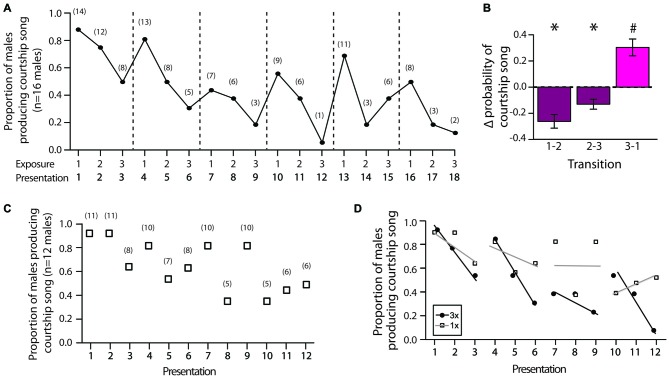
Decreases in the production of courtship song reflect the formation of short-term memories. (A) Plotted are the proportion of male Bengalese finches (n = 16) that produced courtship song across each exposure to the first six stimulus females during 3X tests (range: 6–10 individual females). Dashed lines indicate when the identity of the stimulus female was changed. Numbers in parentheses indicate the number of males producing courtship song for each presentation. (B) The proportion of presentations in which males produced courtship song changed in a systematic manner across exposures (3X tests). Plotted is the mean change (±SEM) in the likelihood of courtship song (i.e., change in the proportion of presentations that an individual male produced courtship song) from the first to second exposure to a female (“1–2”), from the second to third exposure to a female (“2–3”), and from the third exposure to a female to the first exposure to a different female (“3–1”). “*” Indicates significantly less than zero (p < 0.05), and “#” indicates significantly greater than zero (p < 0.05) and different than “1–2” and “2–3”. (C) The proportion of males producing courtship song to individual females gradually decreased over presentations even when the identity of the female was changed after a single exposure (1X tests; 12 stimulus females). Numbers in parentheses indicate the number of males producing courtship song for each presentation. (D) We compared the rates of change in the proportion of males producing courtship song during 3X tests, in which males were consecutively exposed to the same female (presentations 1–3, 4–6, 7–9, and 10–12; black lines), to the rates of change across the same presentations during 1X tests, in which males were consecutively exposed to different females (gray lines). We found that the proportion of males producing courtship song decreased at a faster rate when males were exposed to the same female across presentations than when they were exposed to different females across presentations. For this analysis, only data for males that were administered both 1X and 3X tests were examined (n = 13 males).